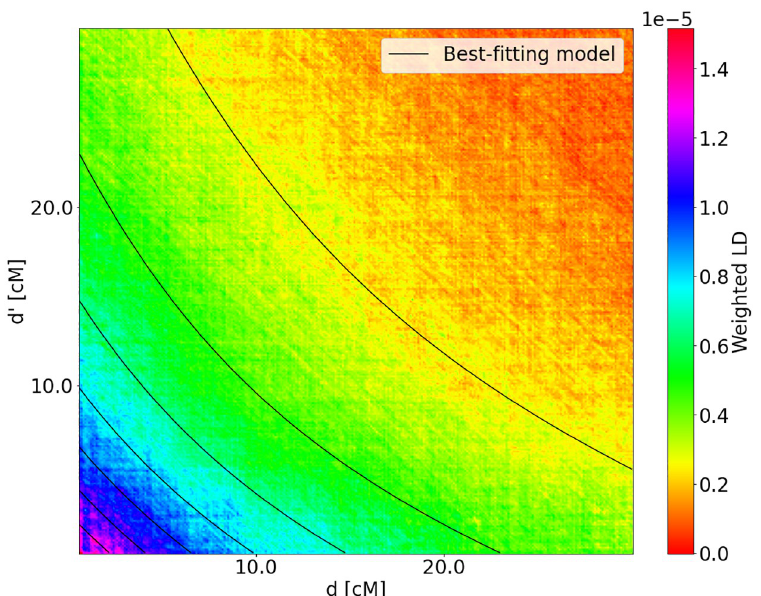
Fig 8. Weighted LD surface for Colombian samples with Yoruba as the first source population reference. The two- pulse model that fits best is two pulses of non-Yoruba admixture at T 1 + T 2 = 14.5 ± 0.74 and T 2 = 3.7 ± 0.62 generations ago. The amplitude of this weighted LD surface is approximately ten times larger than that of the Mexican samples. This is a result of larger proportion of Yoruba ancestry in the Colombian samples. The weighted LD surface was estimated from real data, the level lines correspond to the best-fitting model inferred by LaNeta method.